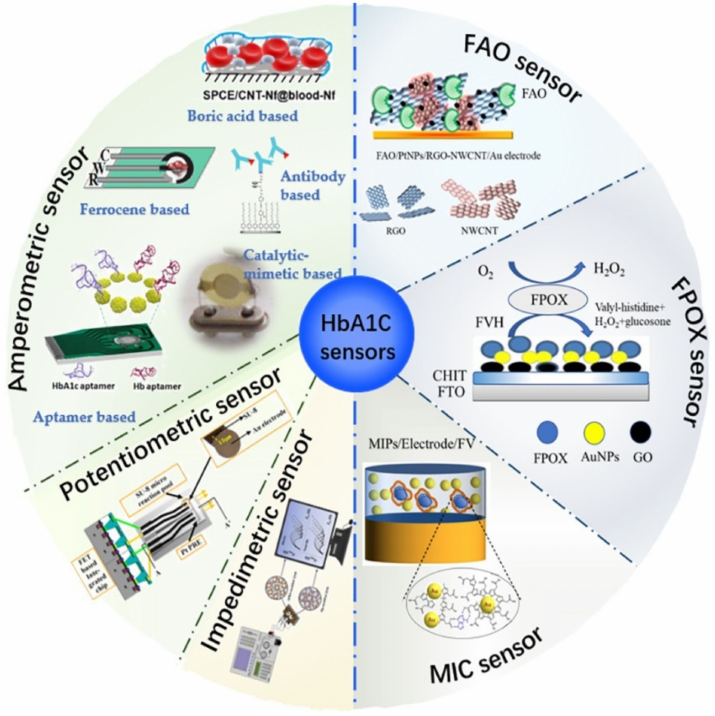
Figure 1. Classification of electrochemical sensors for HbA1c